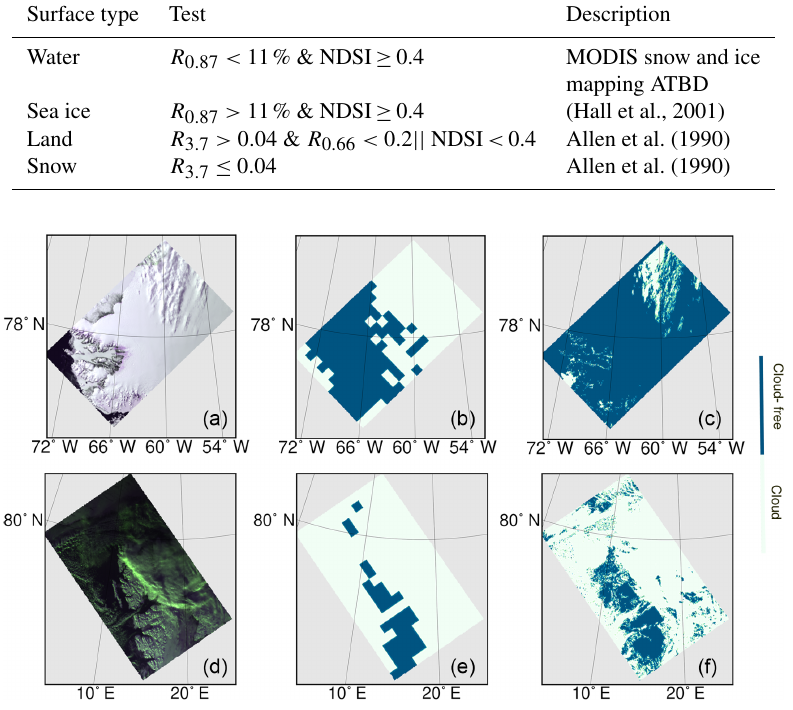
Figure 5. Examples of the results of ASCIA on AATSR observations on the scenes over Greenland (a–c) between 75 ◦ N, 48 ◦ W; 75 ◦ N, 75 ◦ W; 81 ◦ N, 48 ◦ W and 81 ◦ N, 75 ◦ W, taken on 18 May 2008 and Svalbard (d–f) , within 75 ◦ N, 4 ◦ E; 75 ◦ N, 32 ◦ E; 81 ◦ N, 4 ◦ E and 81 ◦ N, 32 ◦ E on 1 March 2008. (a, d) RGB false-colour images (using 0.67, 0.87 and 0.55µm channels), (b, e) cloud detection at block level (25 × 25km 2 ), (c, f) cloud detection at scene level (1 × 1km 2